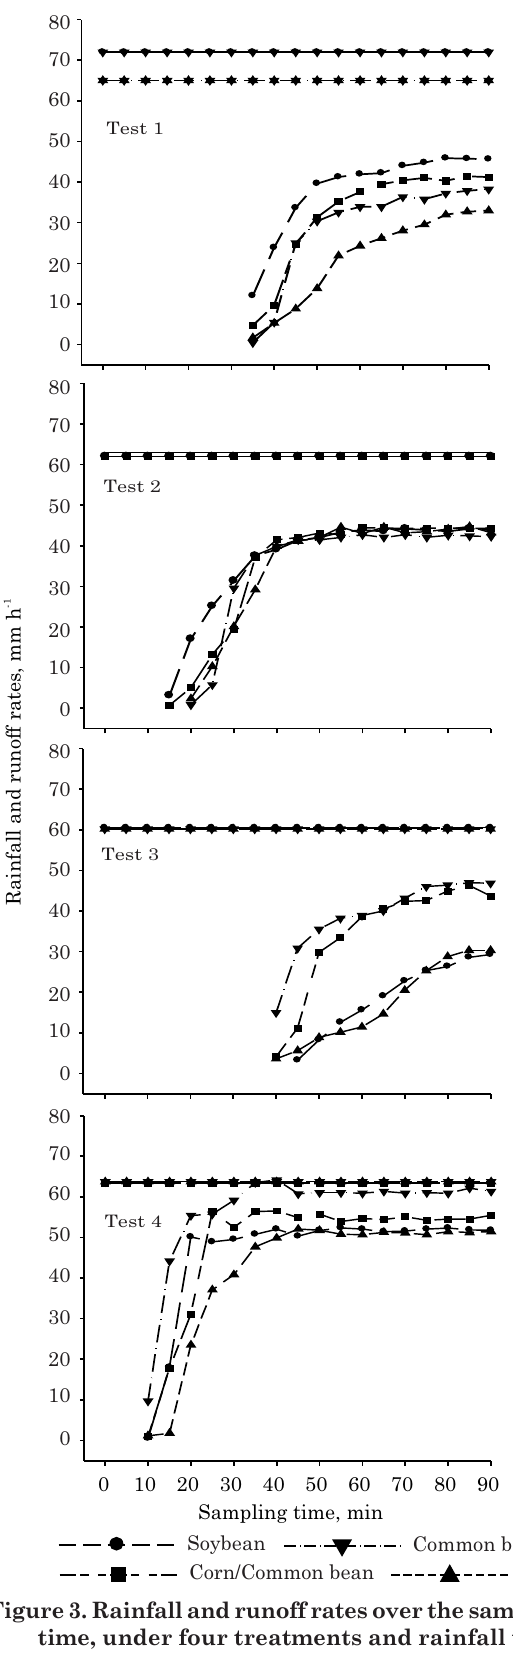
Figure 3. Rainfall and runoff rates over the sampling time, under four treatments and rainfall tests, on a Humic Dystrudept